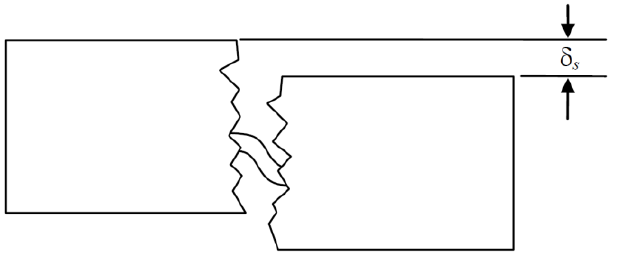
Figure 9. A tension stiffening model.